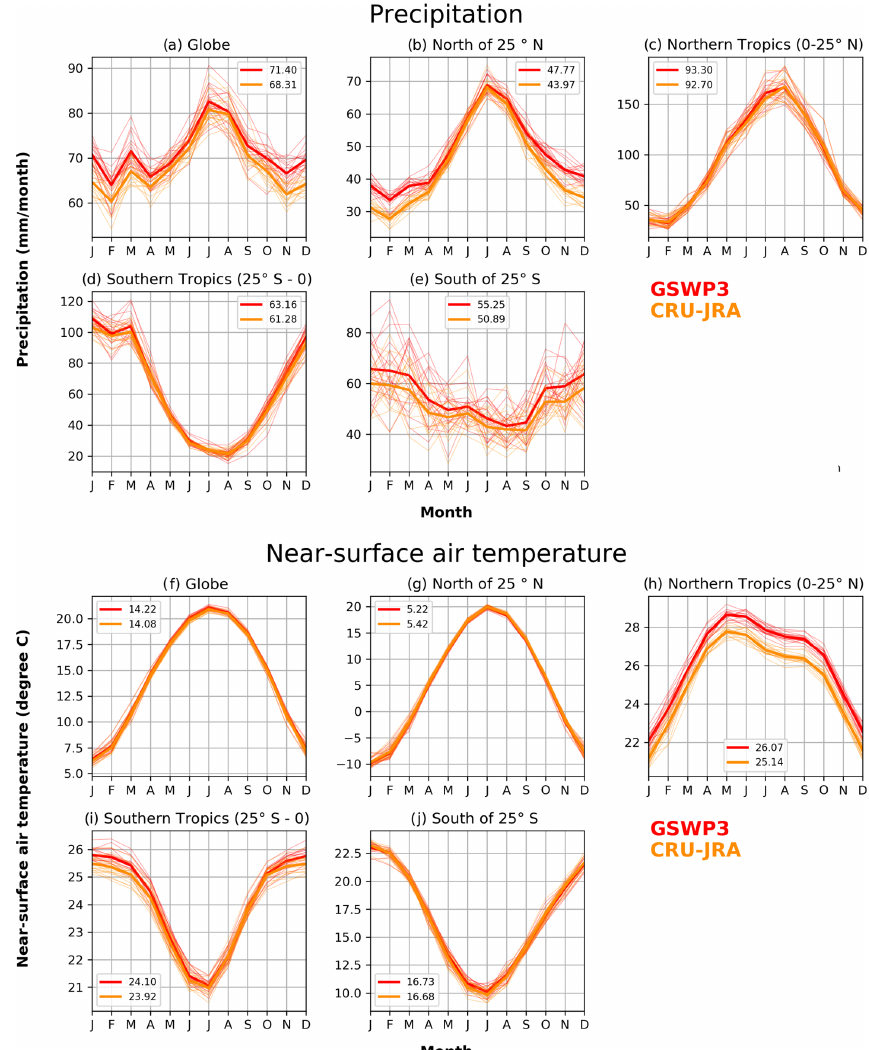
Figure A1. Comparison of monthly precipitation (upper panel) and temperature (lower panel) for five global regions (global, north of 25 ◦ N, northern and southern tropics, and south of 25 ◦ S) from the CRU-JRA and GSWP3 meteorological forcing data sets that are used to drive the CLASSIC model. The global and regional averages exclude Greenland and Antarctica. The legend entries show the annual mean values averaged over the 1997–2016 period. The thin lines show individual years, and the thick line is their